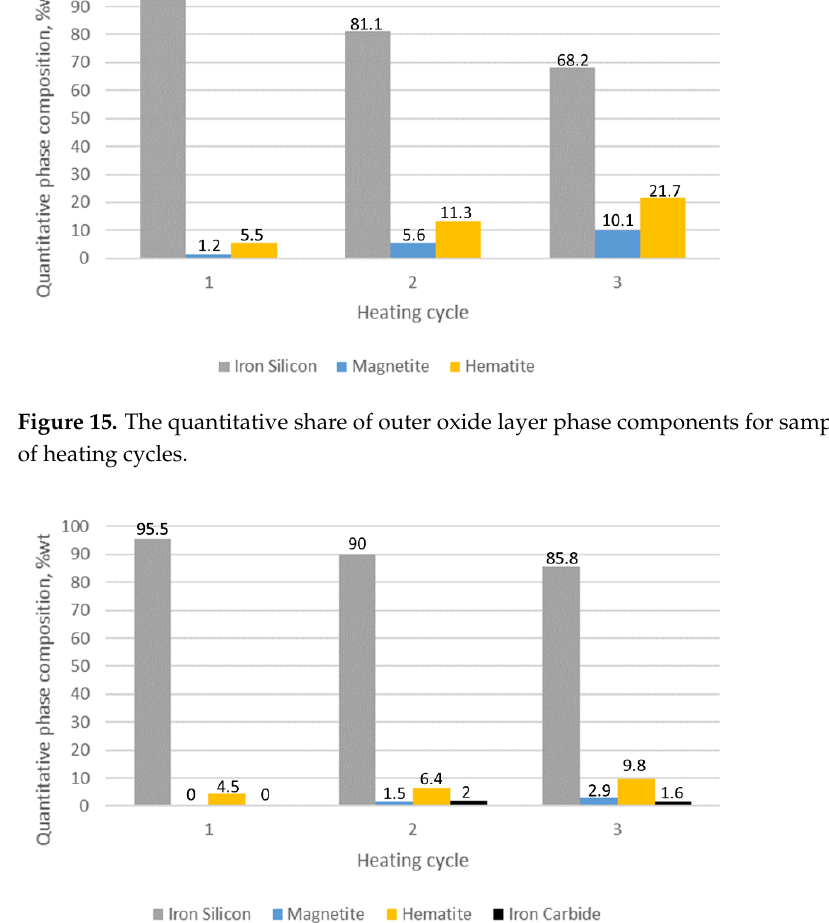
Figure 15. The quantitative share of outer oxide layer phase components for sample 2 as a function of heating cycles.